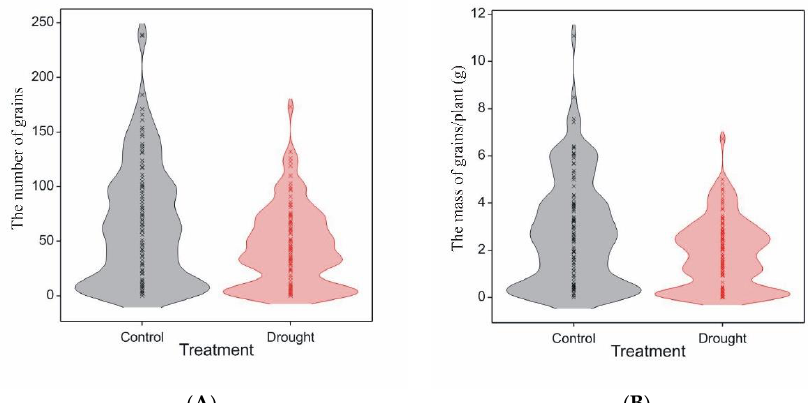
Figure 3. ( A ) The density plot of the number of grains for treatments. ( B ) The density plot of the mass of grains/plant (g) for treatments.